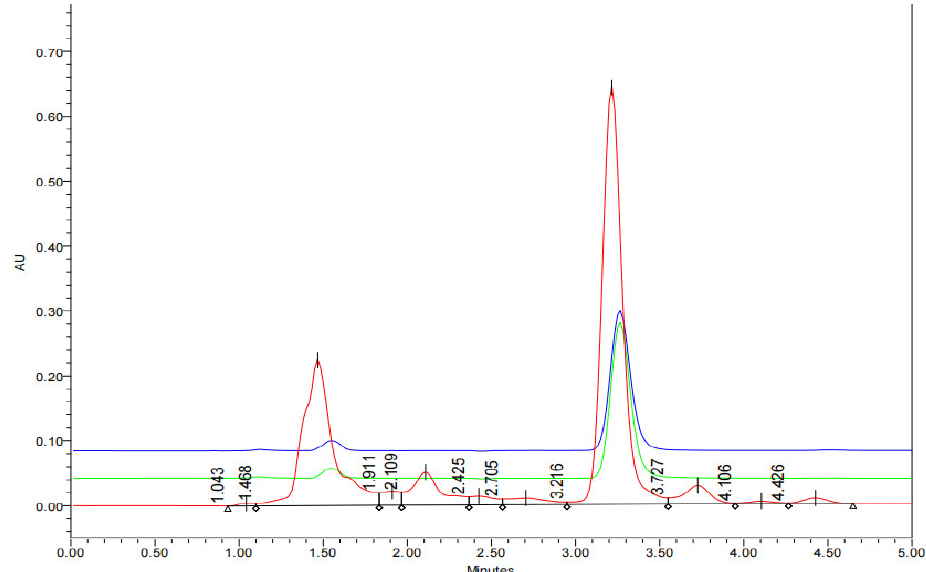
Figure 10. FTIR spectrum of andrographolide standard (blue) and isolate (red).